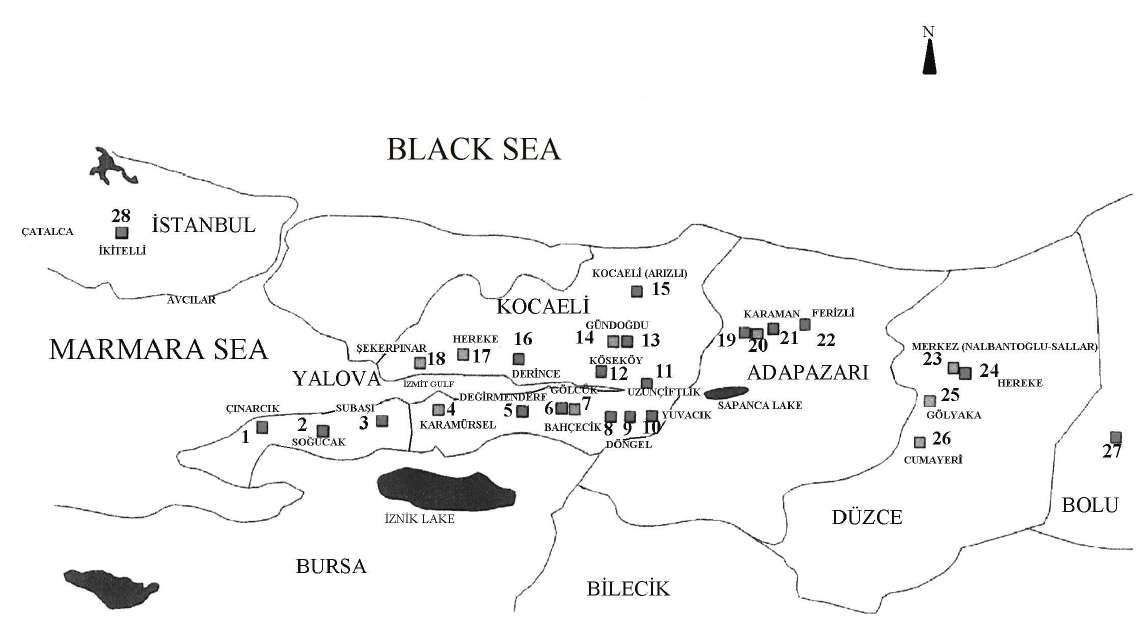
figure 4. 1999 Marmara earthquake permanent housing settlements (MPWS + PIU) (Turkish Ministry of Public Works and Settlement,